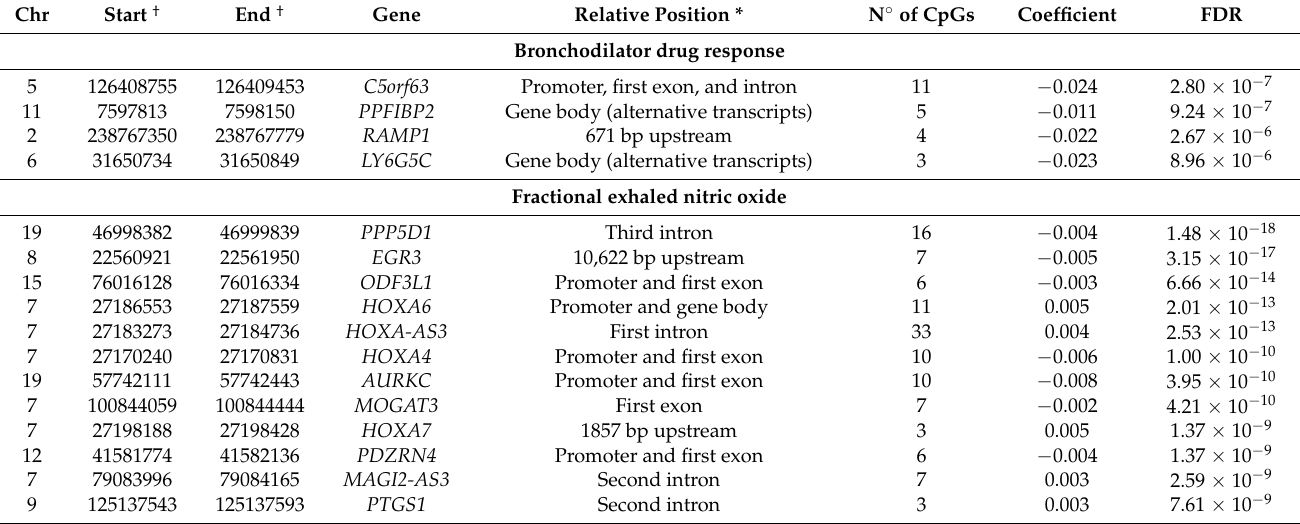
Table 3. Differentially methylated regions associated with BDR and